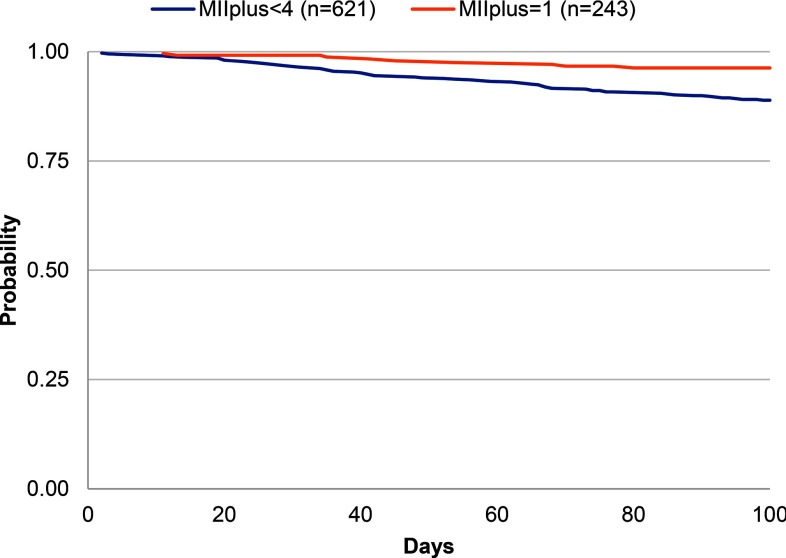
Kaplan-Meier Survival Curves of Contraceptive Continuation by MII With the Added Question About Method Switching (MIIplus) Among IUD Users at EnrollmentAbbreviations: IUD, intrauterine device; MII, Method Information Index.